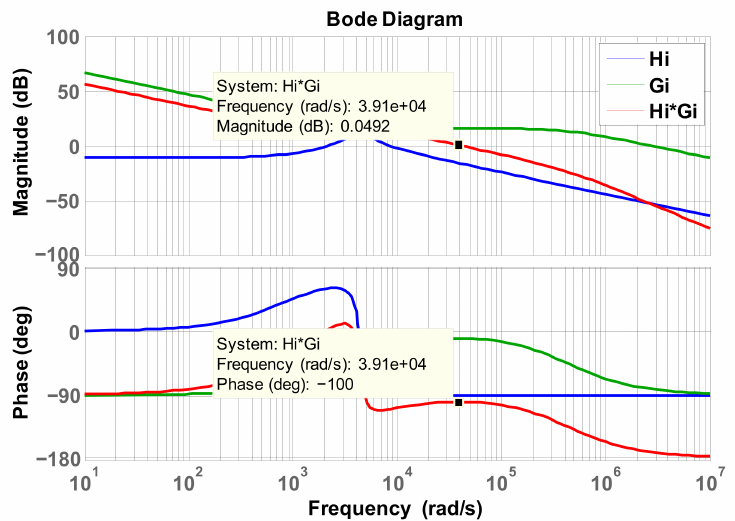
Figure 10. Bode plot of inductor current control